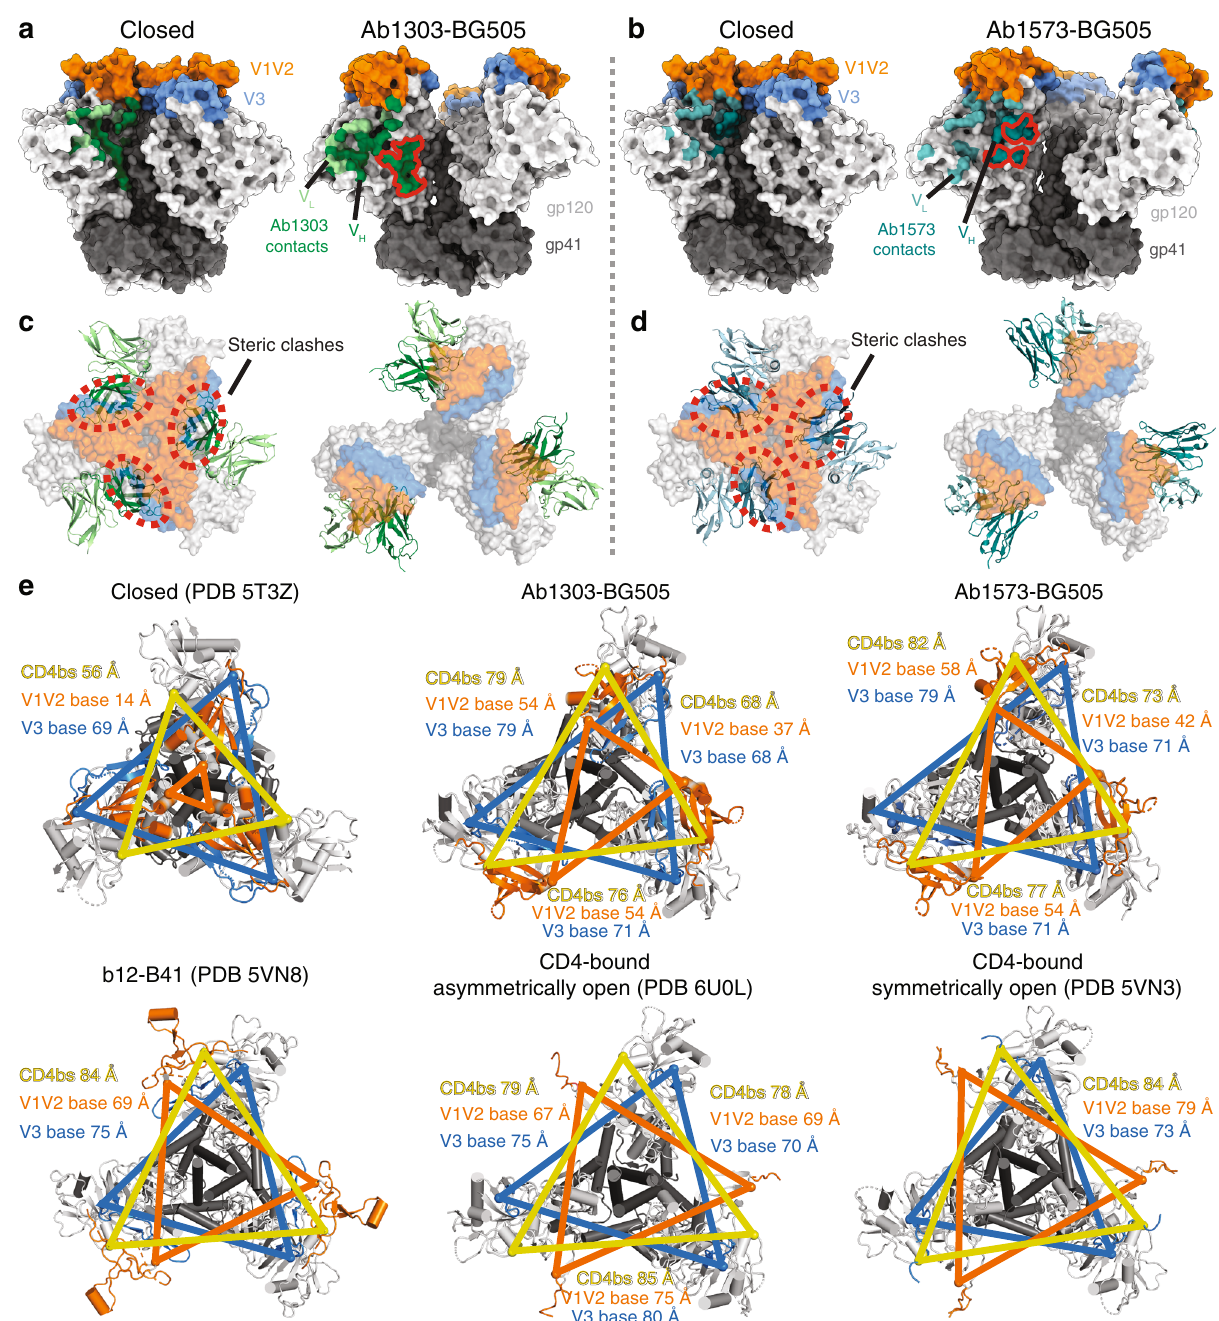
Fig. 5 Ab1303 and Ab1573 bind an Env trimeric state distinct from the closed and CD4-bound open trimer conformations. a , b Ab1303 ( a ) or Ab1573 ( b ) contacts mapped onto a side-view surface representation of a closed BG505 trimer (PDB code 5CEZ) (left) and the occluded-open trimer to which each mAb binds (right). Regions of the antibody epitope that are buried in the closed state but accessible in the Ab1303- or Ab1573-bound state are outlined in red on the occluded-open Env trimer structures. c , d Cartoon representations of Ab1303 ( c ) or Ab1573 ( d ) interacting with closed (left) or occluded-open (right) Env trimers (seen from the top). Regions with steric clashes between the Fab and the closed trimer indicated by dashed, red ovals. e Comparison of inter-protomer distances of C α atoms from selected residues at the CD4bs (yellow), the V1V2 base (orange), and the V3 base (blue) in a closed Env trimer (PDB 5T3Z), Ab1303-bound BG505 trimer, Ab1573-bound BG505 trimer, b12-bound B41 trimer (PDB 5VN8), a CD4-bound asymmetrically-open BG505 trimer (PDB 6U0L), and a sCD4-bound symmetrically-open B41 trimer (PDB